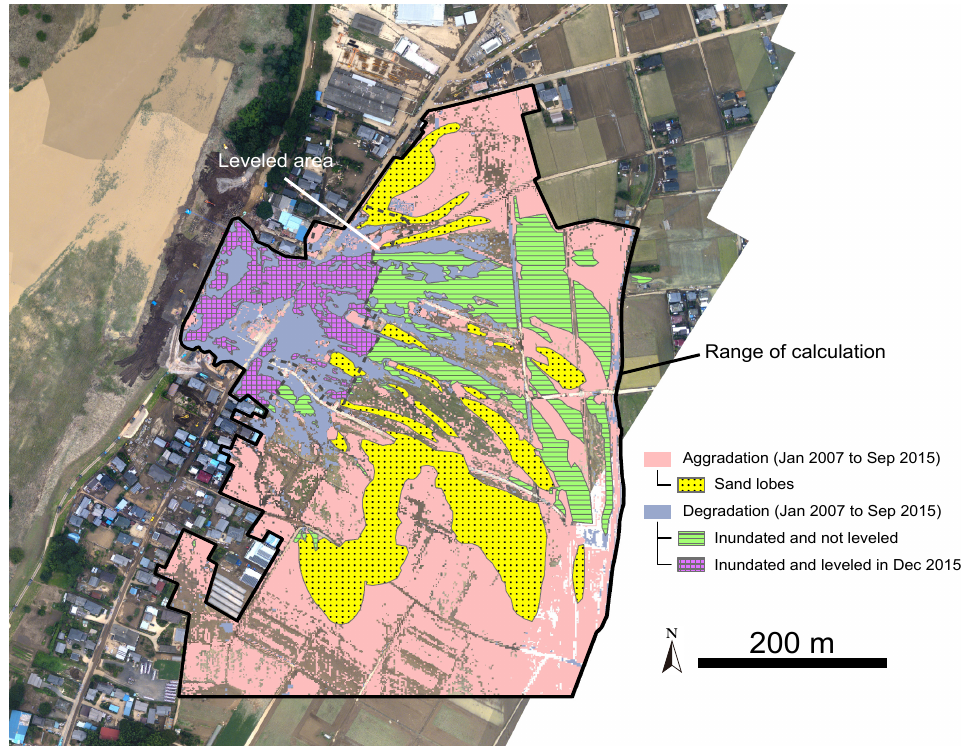
Figure 10. The calculation range used for the volumetric evaluation and the topography types used in the calculation. The areas that were inundated but not leveled in December 2015 (green) contain some aggradational pixels; these pixels were not used in the estimation of water volume, but they were included in the volume